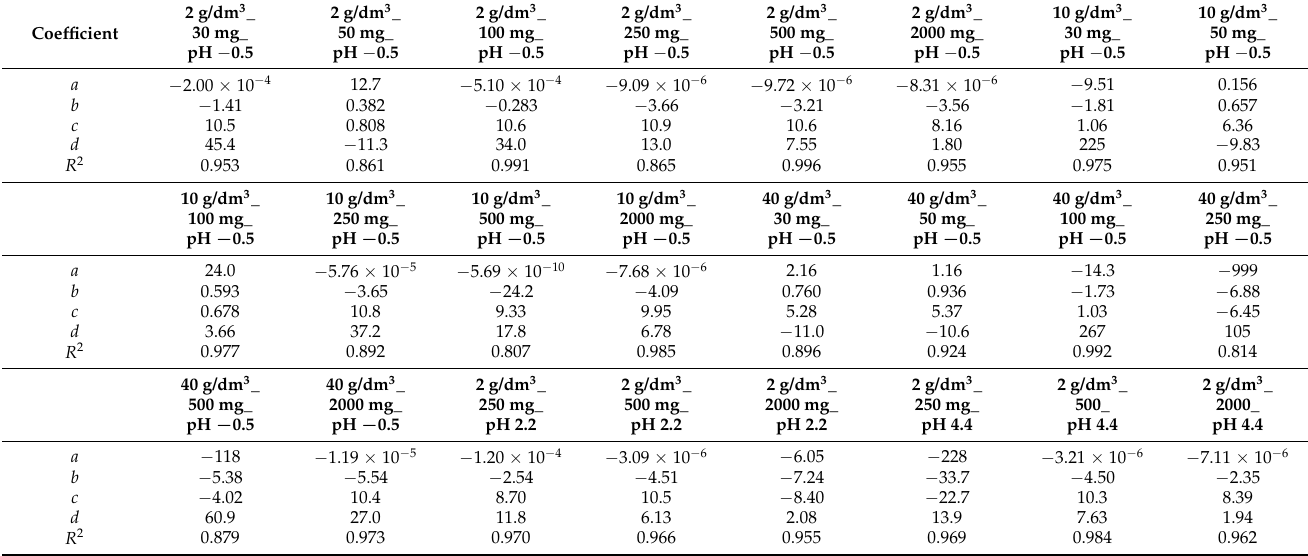
Table A1. a – d parameters of the fitted equation for Dowex G26 (abbreviation: initial concentration of Cr(III)_mass of